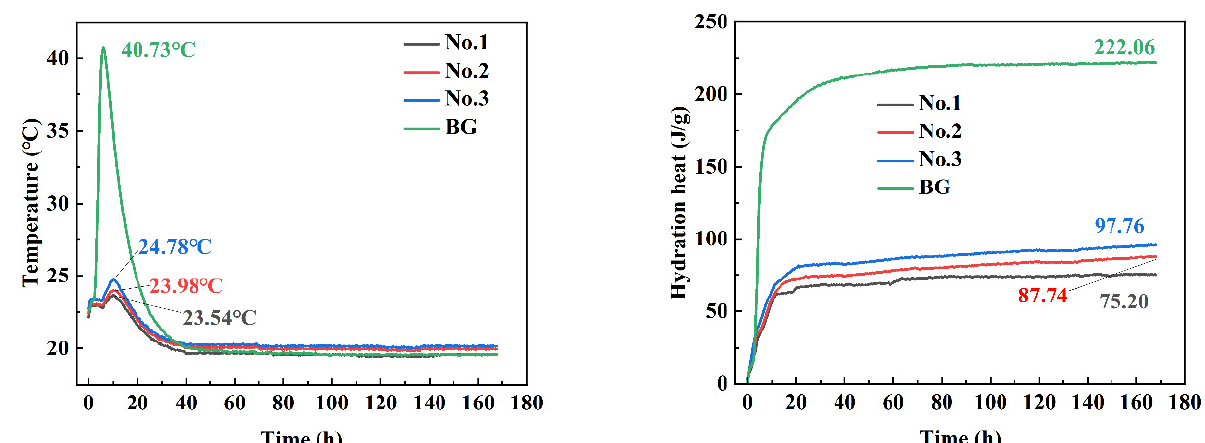
Figure 7. Temperature–time curve ( left ); heat of hydration curve ( right ).